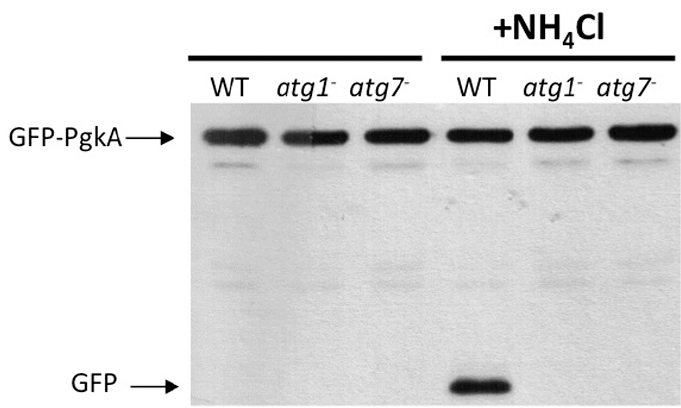
Figure 5. Protein cleavage assay. AX4 wild-type (WT), atg1 - , or atg7 - cells constitutively expressing GFP-PgkA (phosphoglycerate kinase) were subjected to two 150 mM pulses of NH4Cl, each of 2 h, as previously described (see text). Total cell extracts were analyzed by western blot using an anti-GFP antibody. Free GFP cannot be detected in autophagy-deficient strains.